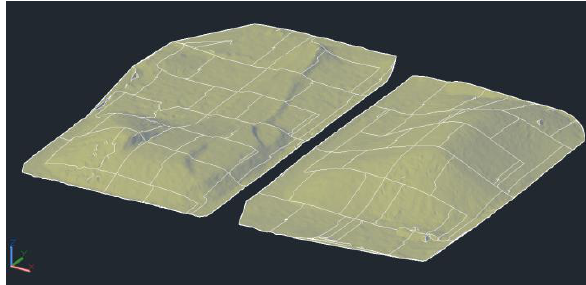
Figure 6. Digital terrain models of heating plant’s coal